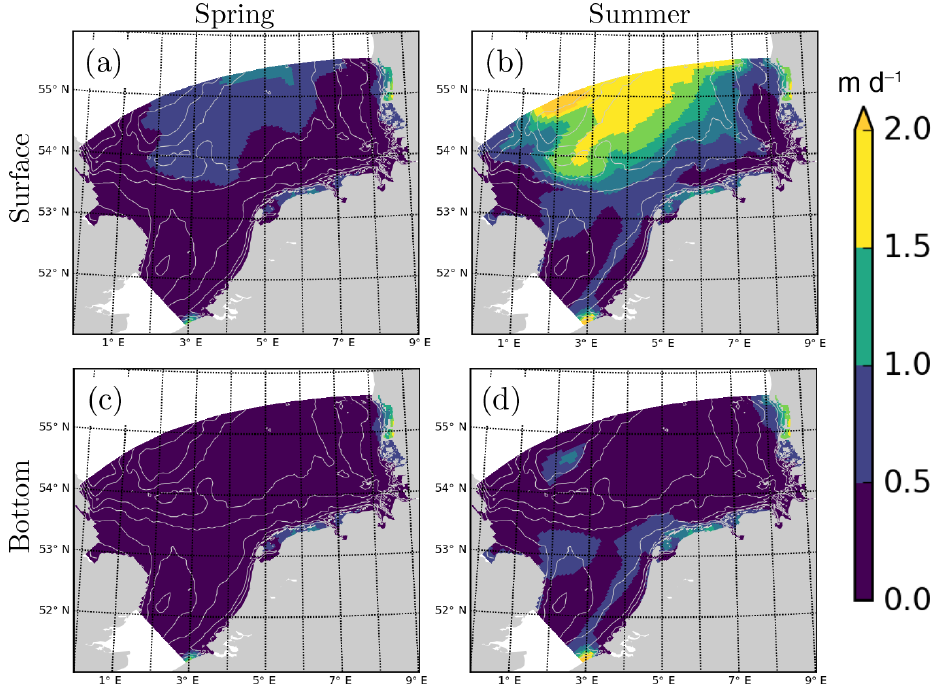
Figure B3. Phytoplankton sinking rates (a, b) at the surface layer and (c, d) at the bottom layer, averaged over spring (months 3–5, left) and summer (months 6–8, right) of